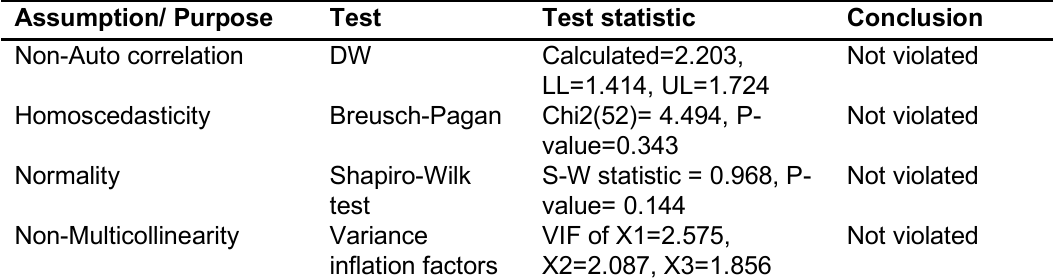
Table 1: Model Diagnostic